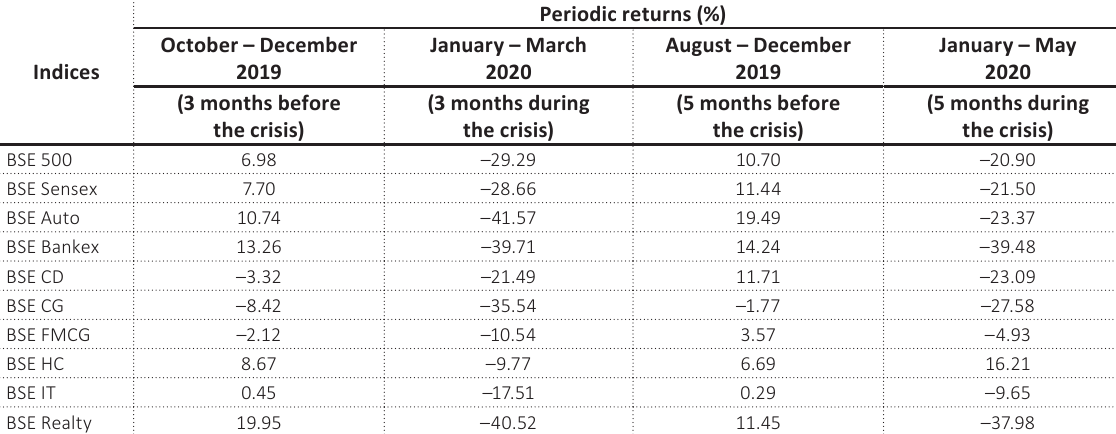
Table 2. Highlights of periodic returns